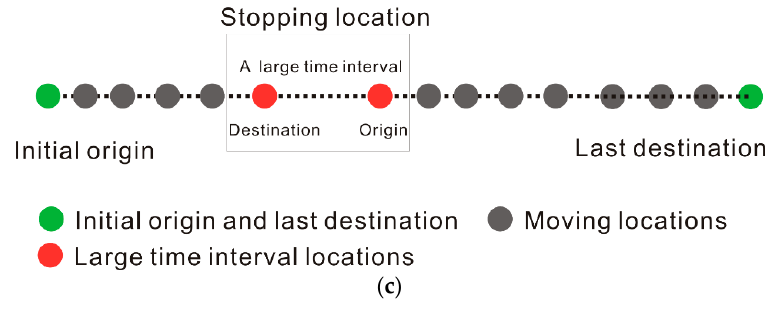
Figure 2. Extracting stopping locations: ( a ) a log-log plot for the power law distributions of the mean values of time intervals of individual taxis with respect to January, March, and August, where the significance tests are conducted with p -values as 0.5, 0.5, and 0.25 for the three months respectively (please refer to [48] for the details on calculating the p -value); ( b ) a log-log plot for the power-law-like distribution of the time interval values of one taxi; ( c ) an illustration on extracting stopping locations from a continuous trajectory.